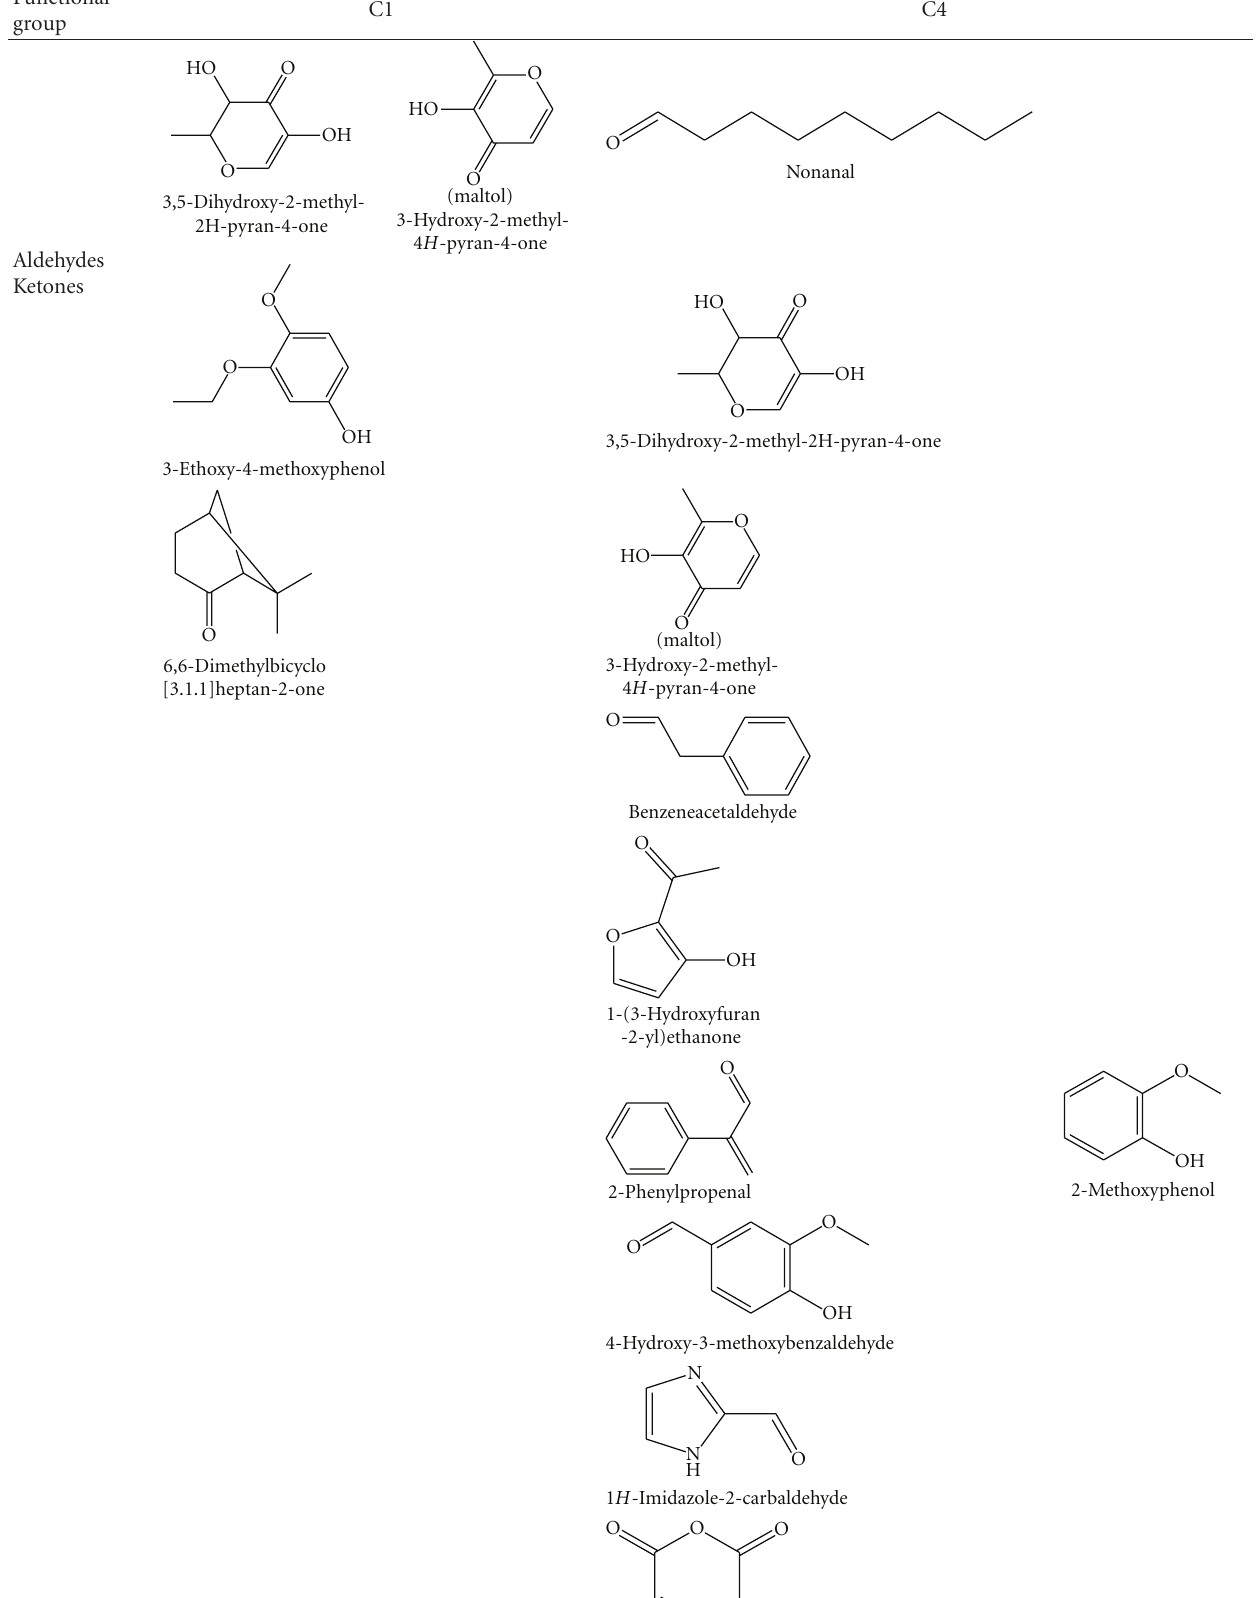
Table 3: Molecular composition of the low-molecular-weight fraction of the extracts from composts C1 and C4. Aldehydes and ketones. Functional C1 C4 group